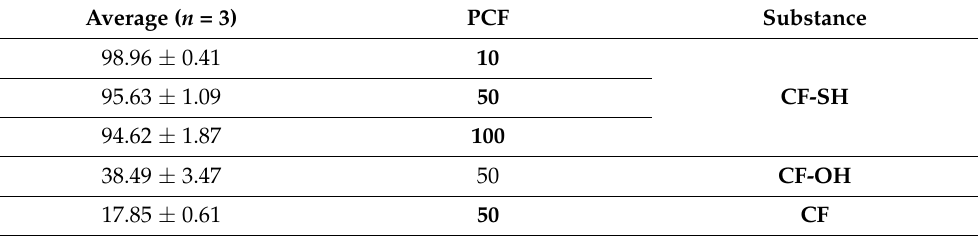
Figure 11. Schematic diagram of extraction process utilising CF-SH for Hg(II)extraction. Table 4. The recoveryRecovery percentage of Hg at different PCFs.